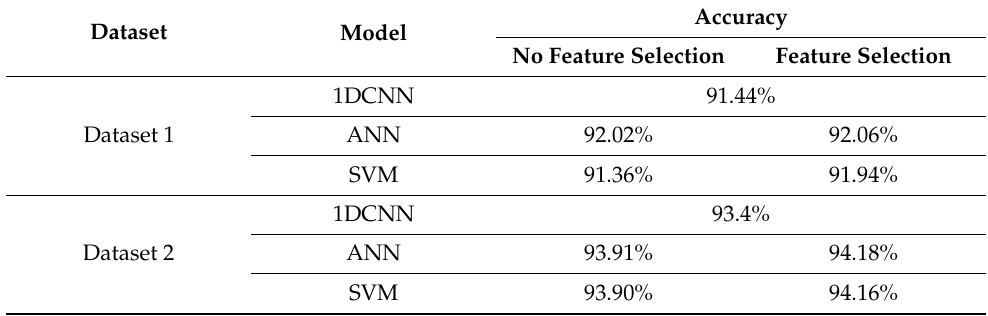
Table 16. The prediction results of the three